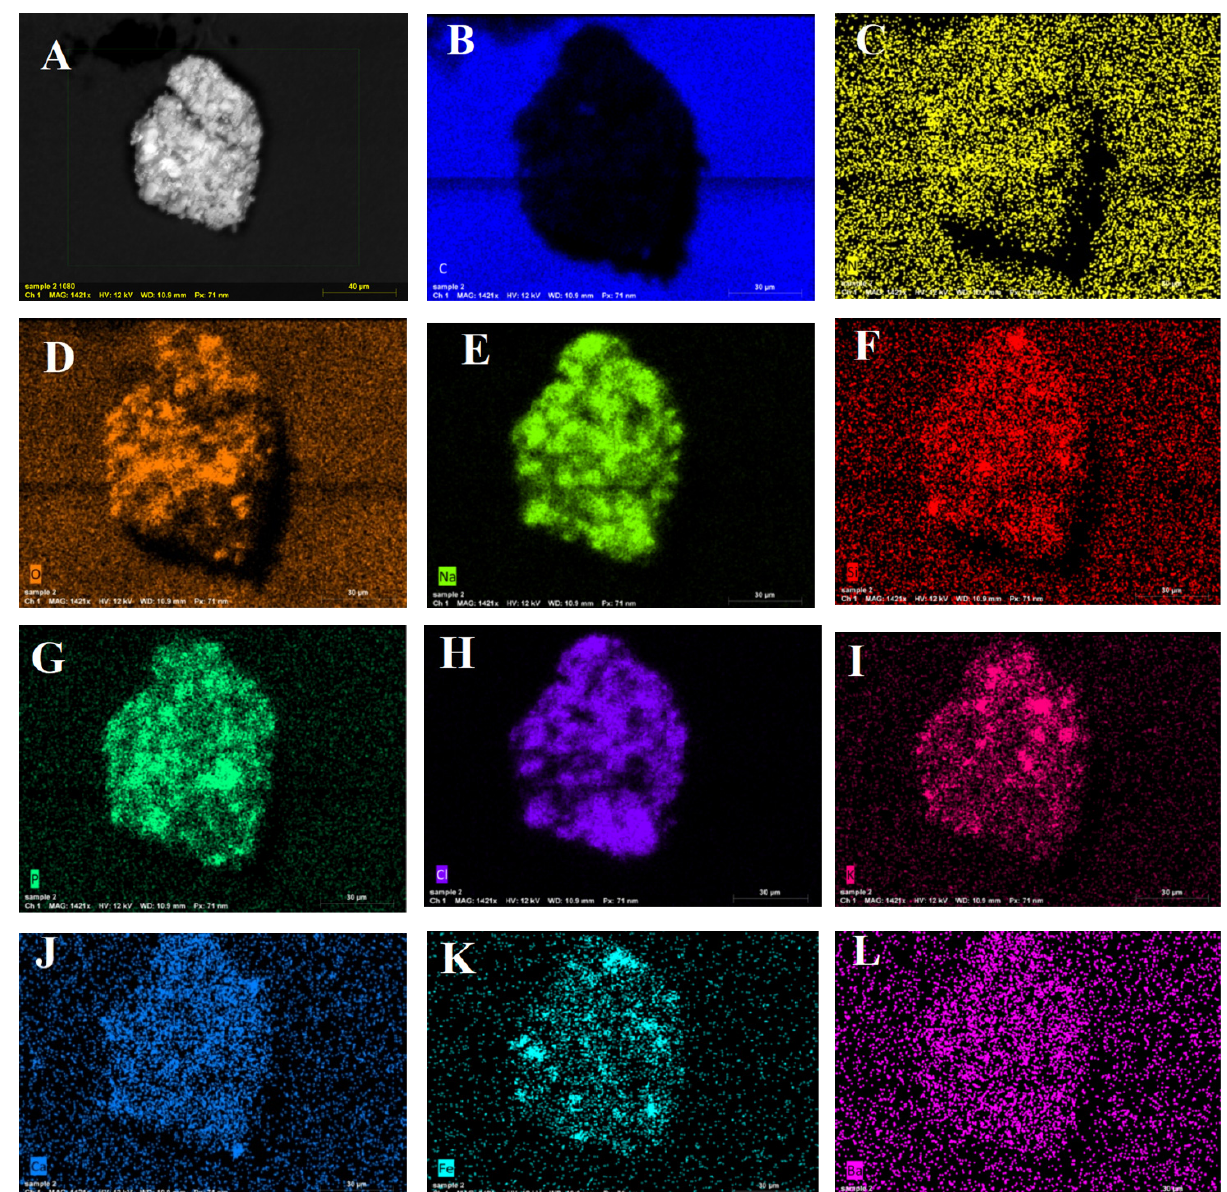
Figure 7. SEM/EDX mapping images of the synthesized alpha-amylase doped on chitosan-loaded barium ferrite nanopar- ticles. ( A ) Alpha-amylase-CLBFNPs,( B ) Carbon, ( C ) nitrogen, ( D ) oxygen, ( E ) sodium, ( F ) silicon, ( G ) phosphorus, ( H ) chlorine, ( I ) potassium, and ( J ) calcium atoms were for glutaraldehyde used in crosslinking during the immobilization, alpha-amylase, chitosan, and sodium phosphate buffer. The presence of ( L ) Ba and ( K ) Fe atoms of barium ferrite appears as condensed bright distribution (pink and turquoise colors,